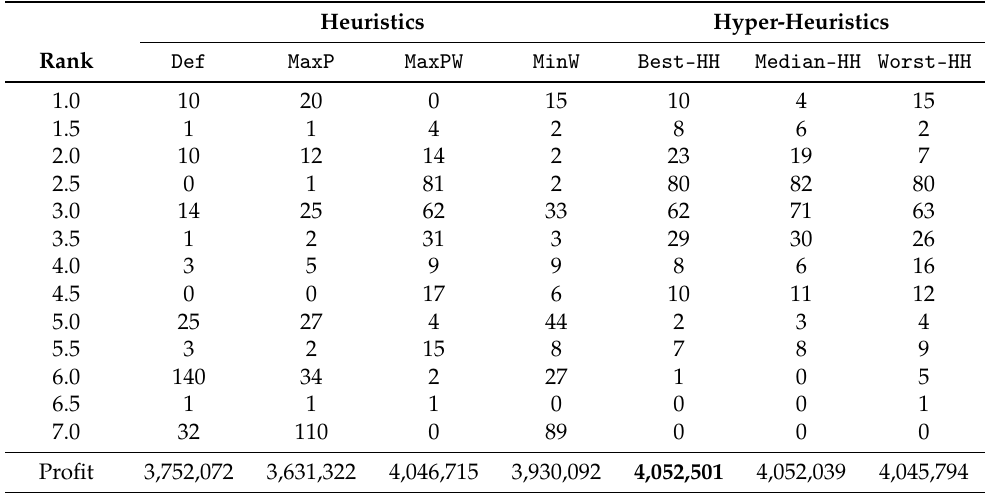
Table 9. Ranks and total profit obtained by the four heuristics and the best, median, and worst hyper-heuristics trained on 60% of set β 2 and tested on the remaining 40% of set β 2 . The best result, measured in terms of total profit, is highlighted in